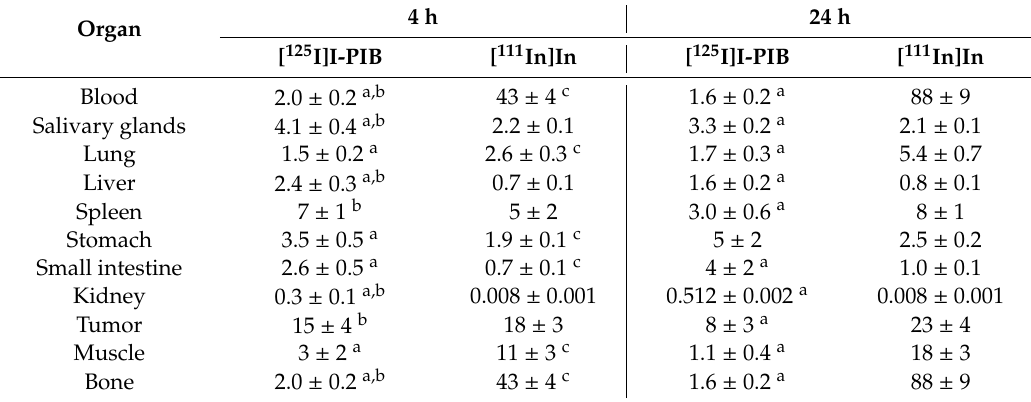
Tumor-to-organ ratios for [ 125 I]I-PIB-(HE) 3 -Z HER3:08698 -DOTAGA and [ 111 In]In-(HE) 3 - Z HER3:08698 -DOTAGA in Balb / c nu / nu mice bearing BxPC3 xenografts at 4 and 24 h pi. Results are presented as average ± SD of four